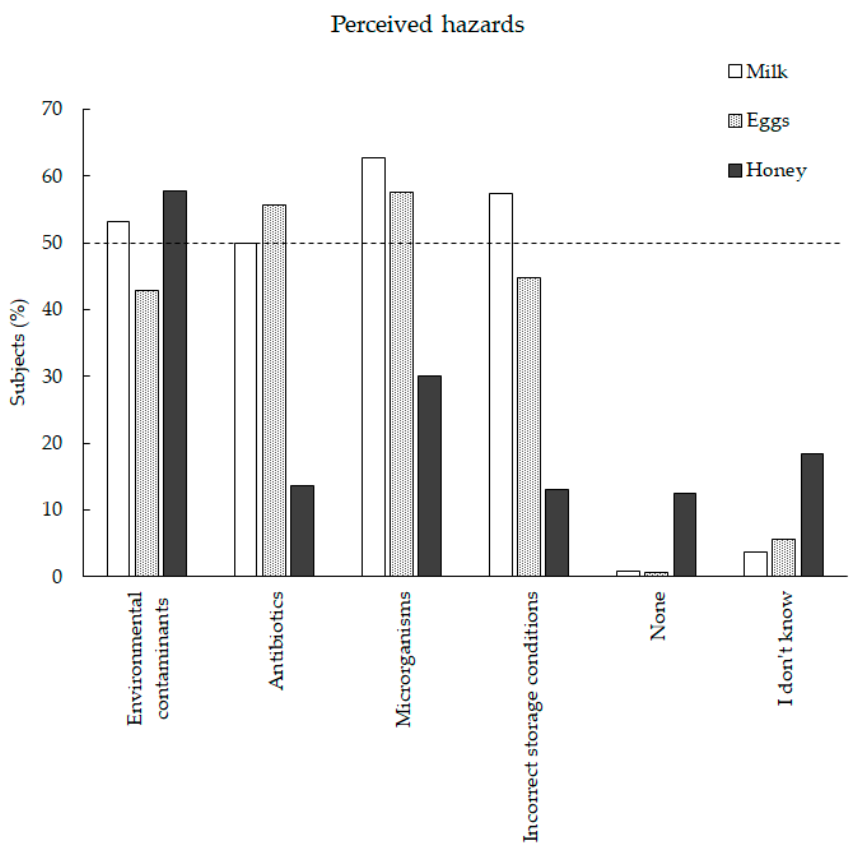
Figure 2. Percentage of respondents ( n = 489) selecting characterizing hazards for the three considered product categories. Note: the dotted line indicates hazards chosen by at least 50% of respond- ents.